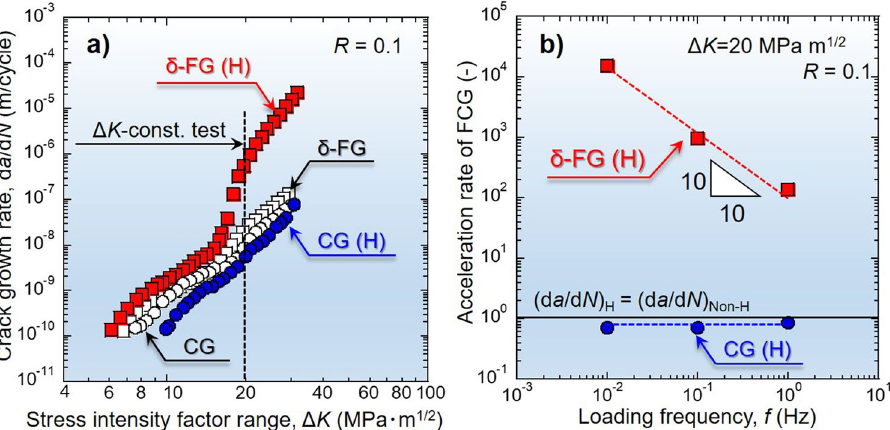
Figure 1. FCG properties under the absence and presence of H for δ-FG and CG: ( a ) Relationship between FCG rate, d a /d N , as a function of stress intensity factor range, Δ K , obtained by Δ K -increasing and -decreasing tests. ( b ) Relationship between acceleration rate of FCG, (d a /d N ) H /(d a /d N ) Non-H , as a function of loading frequency, f , obtained by Δ K -constant tests. (d a /d N ) H /(d a /d N ) Non-H = 1 means no acceleration of FCG by the presence of